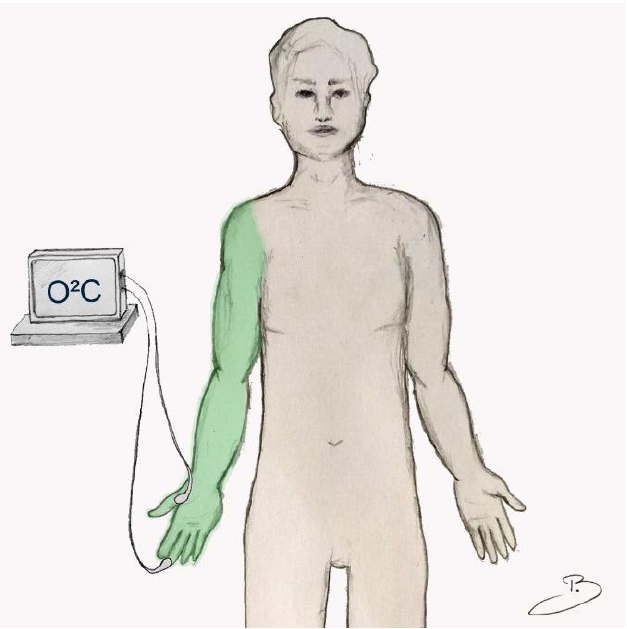
Figure 1. Study se-up: two probes of an “O2C-device” ( © LEA Medizintechnik, Gießen, Germany) were attached to the palmar skin of the finger pulp (penetration depth 1–2 mm) and the thenar prominence (penetration depth 7–8 mm) for continuous assessment of microcirculatory changes. After a 10 min period of strict rest, the ipsilateral axillary plexus blockade was conducted (marked in green).